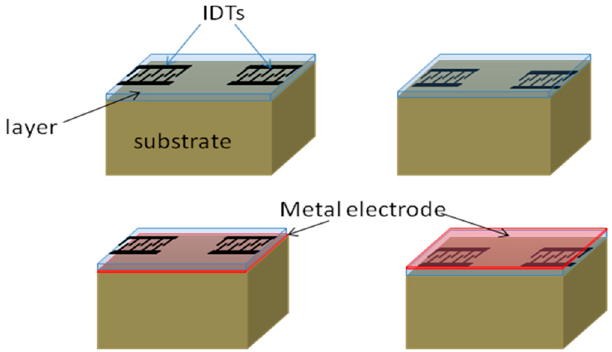
Figure 7. The four different coupling configurations.